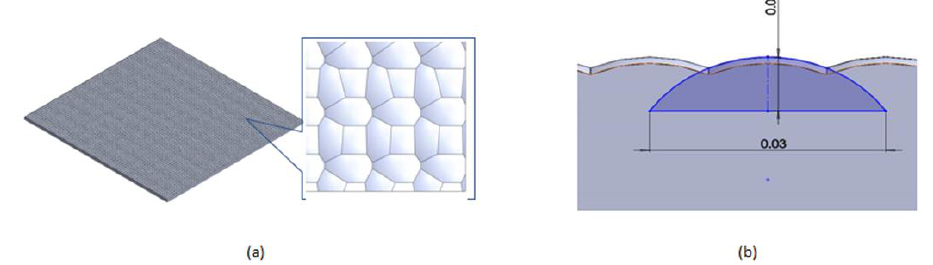
Figure 4. The convex share of the microstructure of diffuser on top lens. ( a ) views from the top of the chip with microstructure diffuser and ( b ) the cross-sectional view of diffuser microstructure.